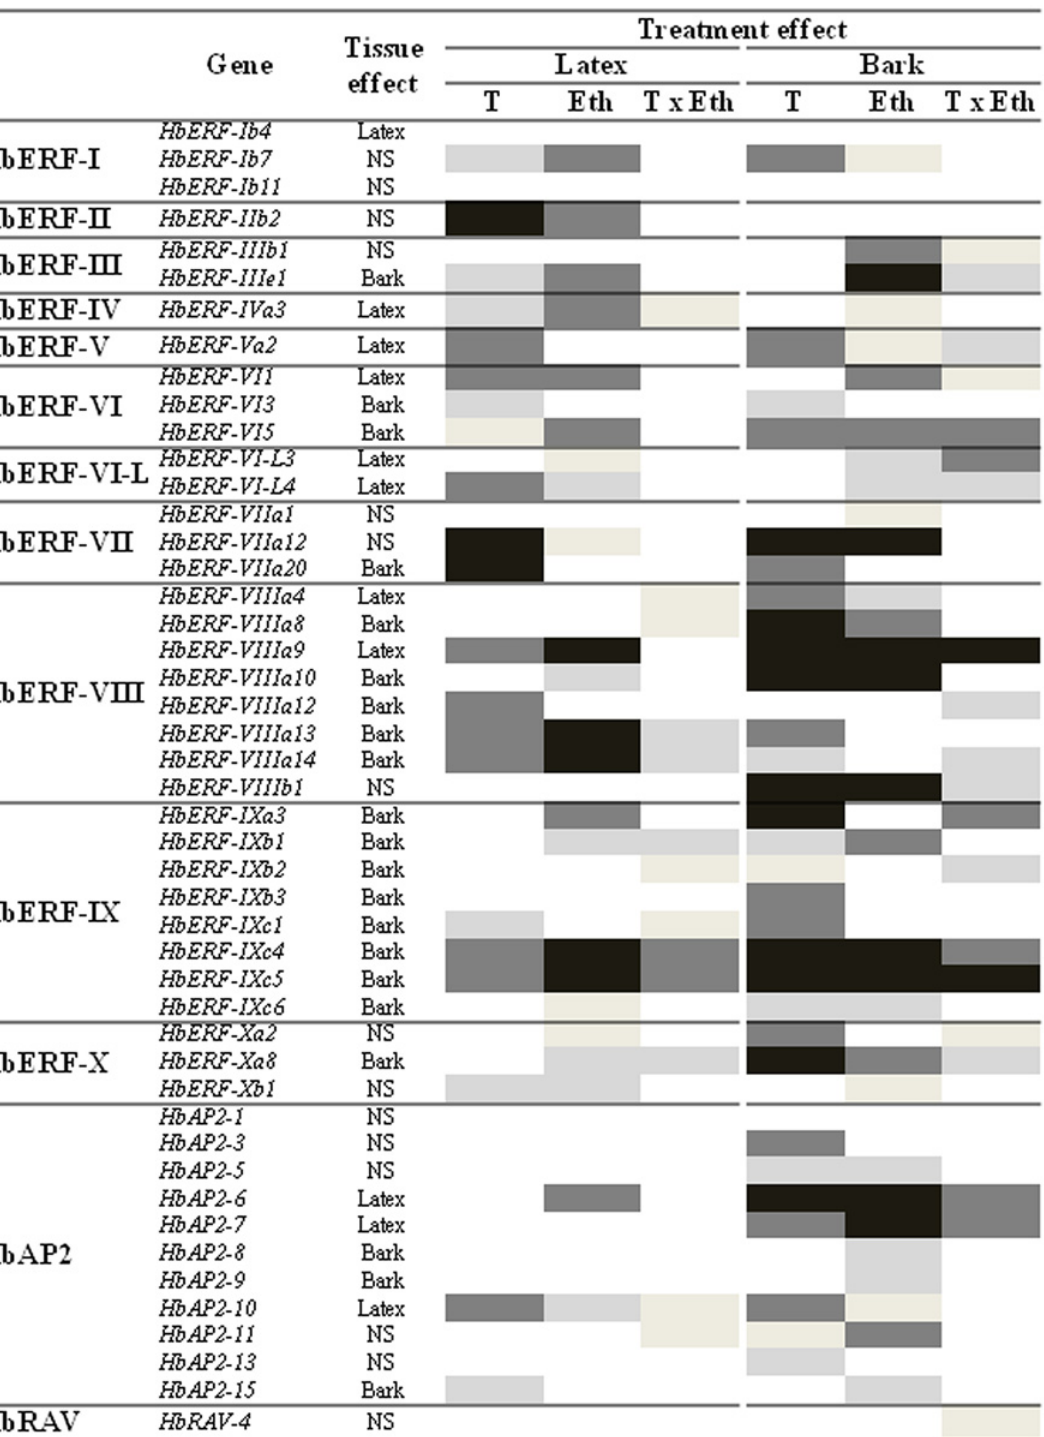
Fig 2. Interaction analysis profile of 47 AP2/ERF genes of Hevea brasiliensis in latex and bark tissues of mature trees during latex harvesting. P- values are indicated from black to white as follows: 0.001; 0.01; 0.05; 0.1 and non-significant data. T: tapping; Eth: ethephon; TxEth: combination of both.